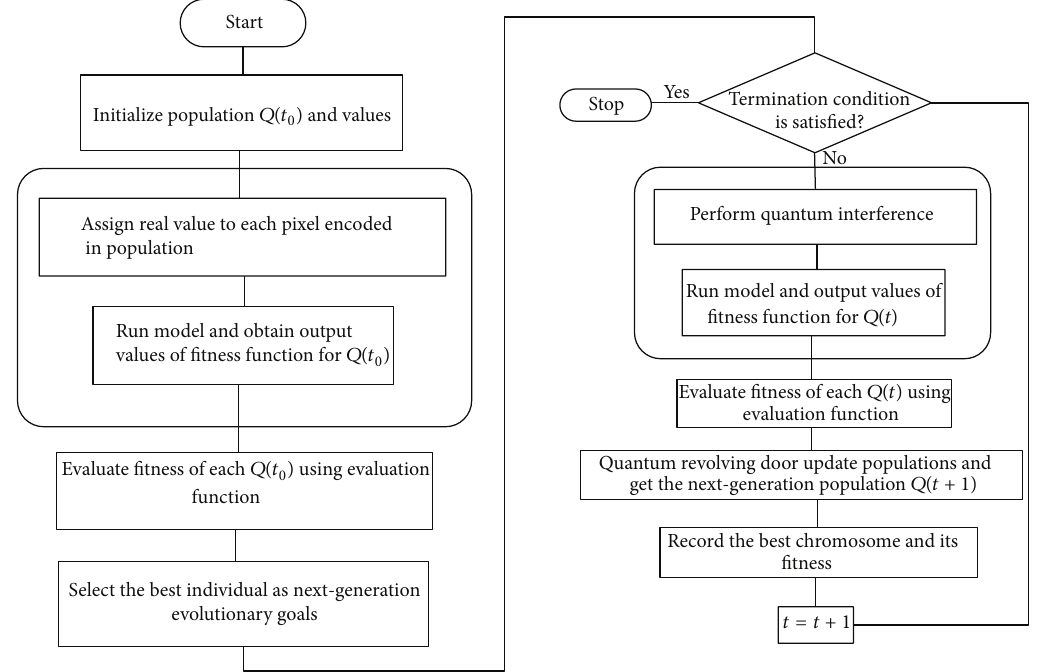
Figure 2: The proposed algorithm for quantum genetic